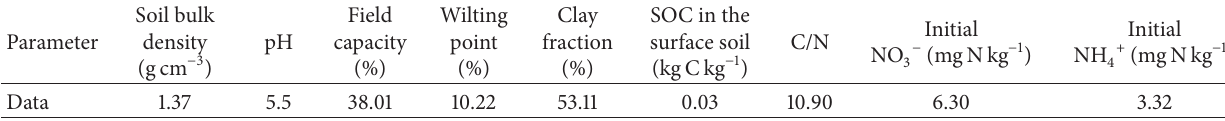
Table 1: Input parameters used in the DNDC model (0–20cm).